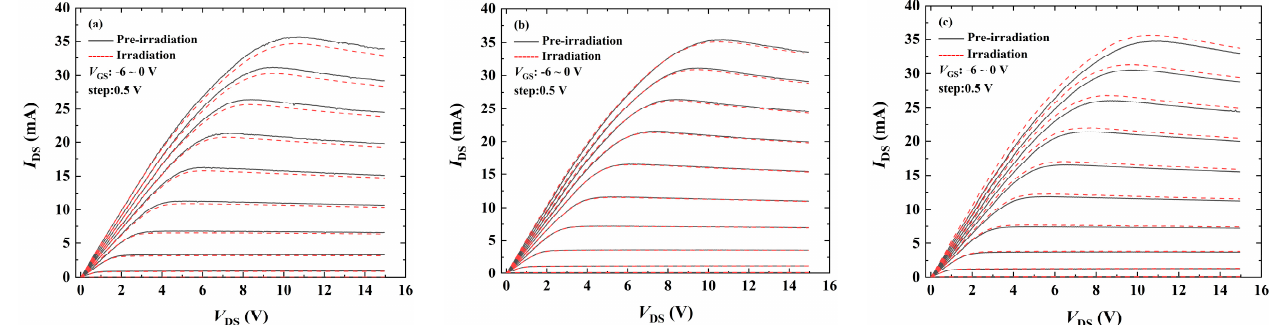
Figure 4. Measured I DS – V DS curves of Device 1 before (“Pre-irradiation”) and after (“Irradiation”) proton irradiation with 1 MeV ( a ), 0.6 MeV ( b ), and 0.4 MeV ( c ) proton energies.